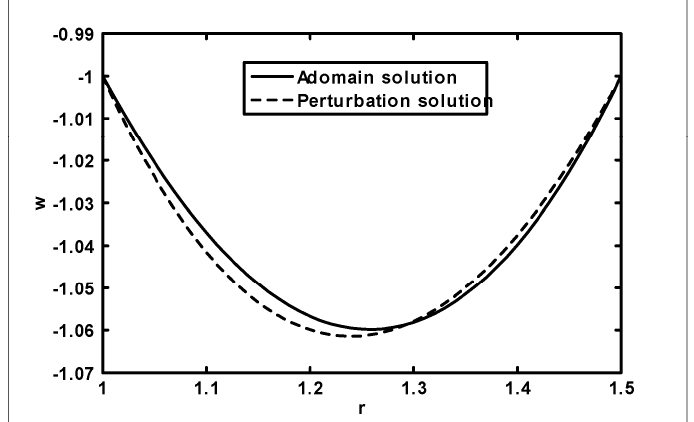
Figure 4. The variation of friction force F ( 1 ) (inner tube) with Q for di ff erent values of M at r 1 = 0.4, φ = 0.4, when µ = 1.